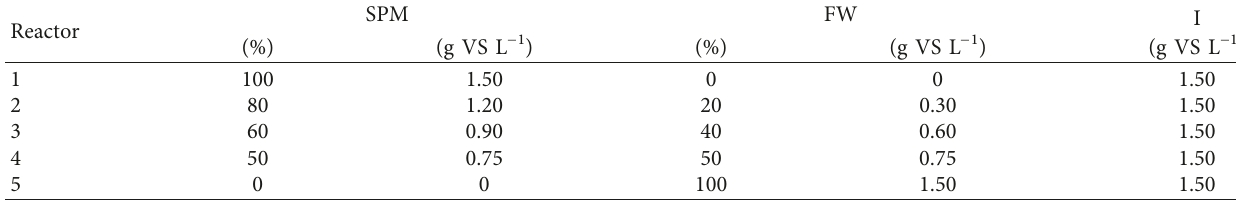
Table 1: SPM:FW ratios evaluated in each reactor.